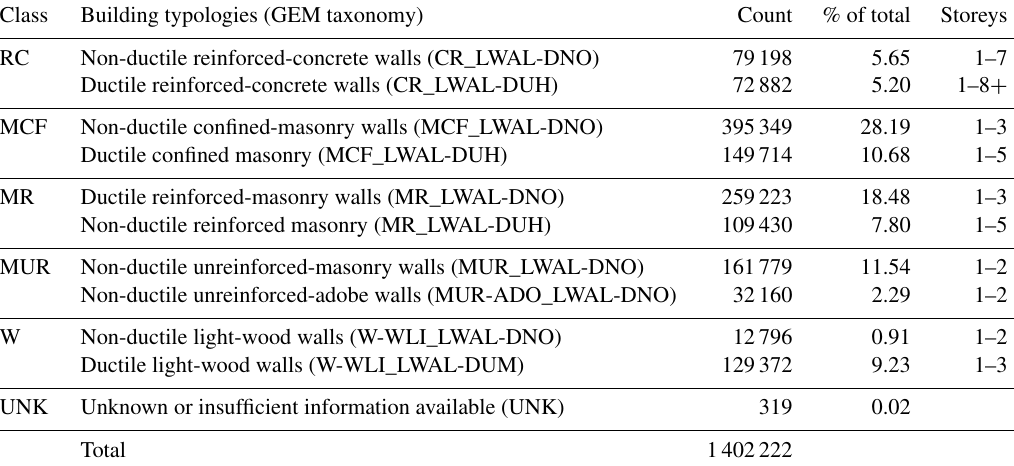
Table 1. Summary of the building classes and typologies in our Santiago residential-building exposure model, based on Yepes-Estrada et al. (2017).